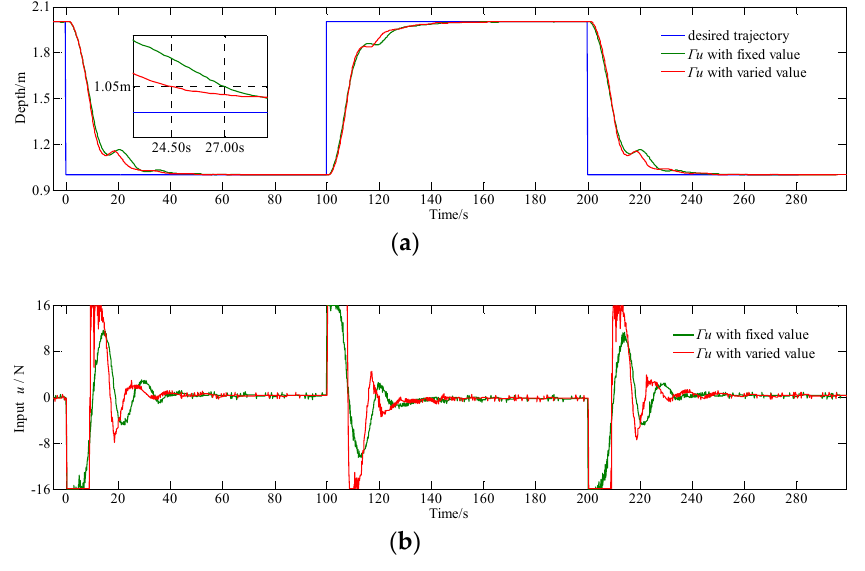
Figure 8. Contrast experiment result for model predictive control (MPC) with fixed Γ u and adjusting Γ u tracking step trajectory. ( a ) Depth data for MPC with fixed Γ u and adjusting Γ u ; and, ( b ) input u for MPC with fixed Γ u and adjusting Γ u . Table 1. Settling Time Results of Figure 8.